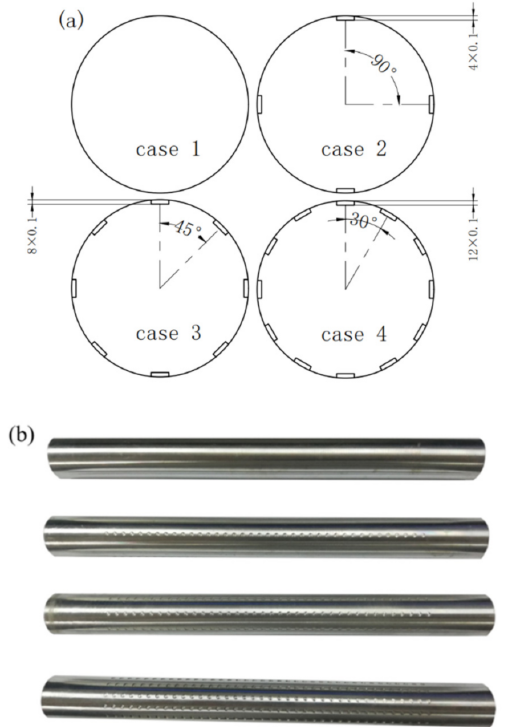
Figure 2. The cylinders used in the experiment: ( a ) the schematic sketches of the cylinder cross sections, ( b ) the finished cylinders.